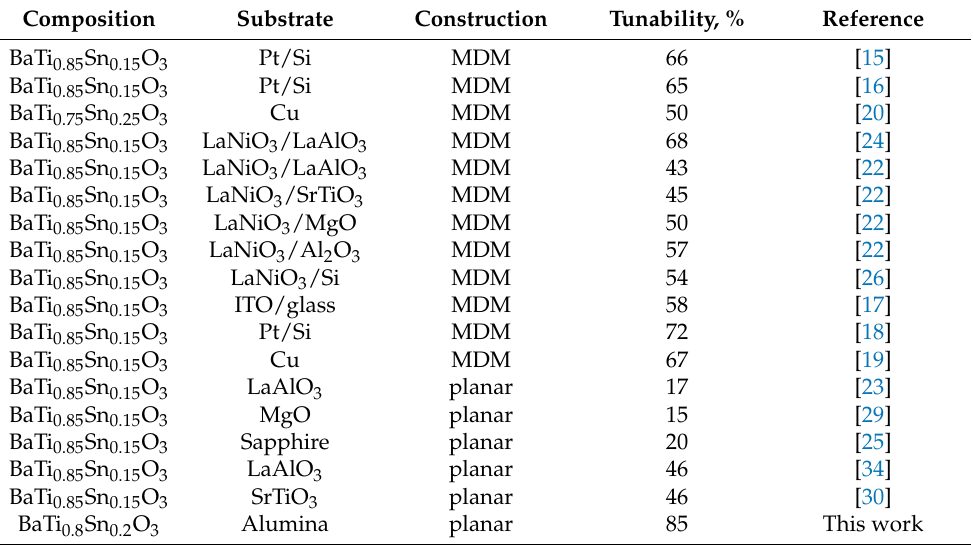
Data on the tunability of MDM and planar capacitors based on barium titanate- stannate